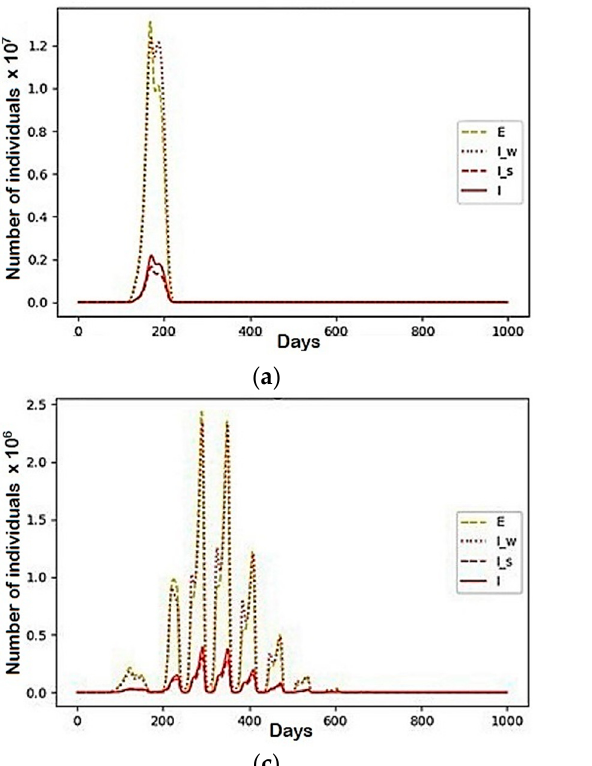
Figure 9. A scenario in which 𝑎 (cid:2869) = 1, 𝑏 (cid:2869) = −0.1, 𝑏 (cid:2872) = 0.05, 𝑐 (cid:2869) = −0.15, 𝑐 (cid:2872) = 0.1, 𝑑 (cid:2869) = −0.3,𝑑 (cid:2870) = −0.7 , and the rest are equal to zero: ( a ) Region 1; ( b ) Region 2; ( c ) Region 3; ( d ) Region 4.